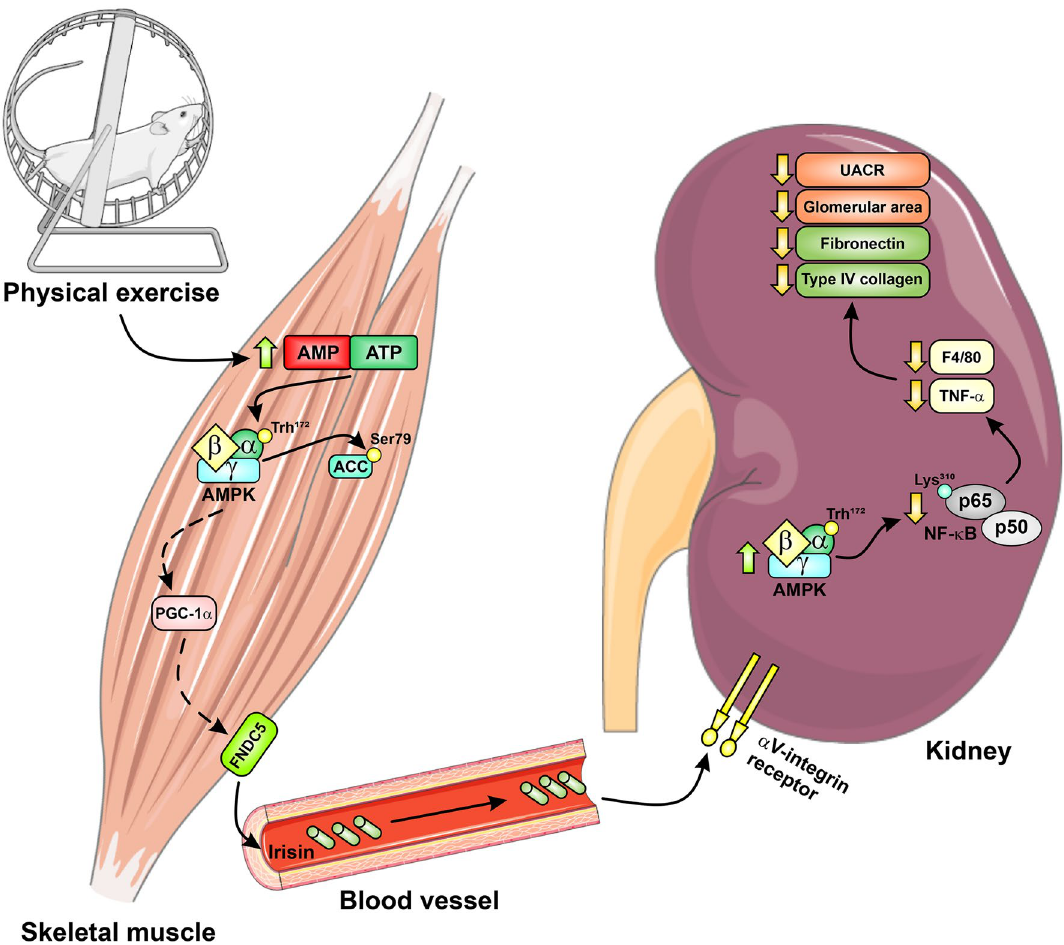
Figure 6. Schematic representation of the mechanism by which irisin/AMPK may mediate the role of physical exercise in inducing renal protection in diabetes. Interrupted arrows linking muscle AMPK, PGC1 and FNDC-5 indicate that the pathway requires further